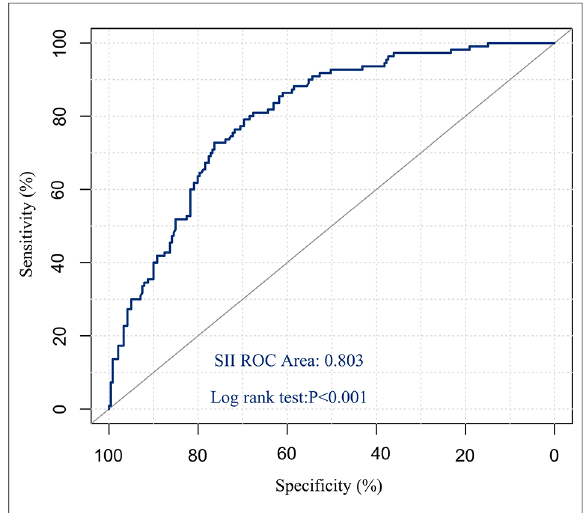
FIGURE 1 ROC curve of preoperative SII predicting overall survival in patients with hepatic hydatid